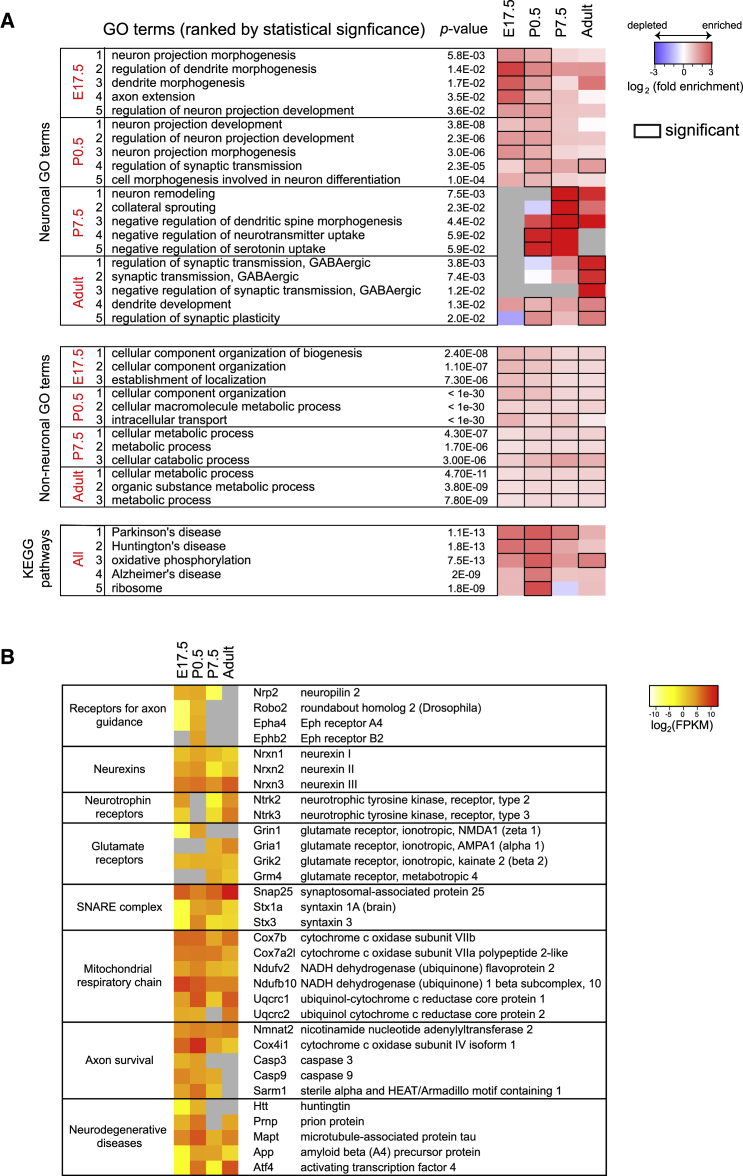
Developmental Changes of Translated Genes in RGC Axons(A) Enriched GO (biological process) terms and Kyoto Encyclopedia of Genes and Genomes (KEGG) pathways for axonally translated genes (grey, not detected), sorted by significance for each stage (Fisher’s exact test). The enrichment was analyzed by topGO (Table S3). Statistically significant cells are marked by black squares.(B) Normalized levels of axonal translation for selected genes (gray, not detected).See also Figure S4.